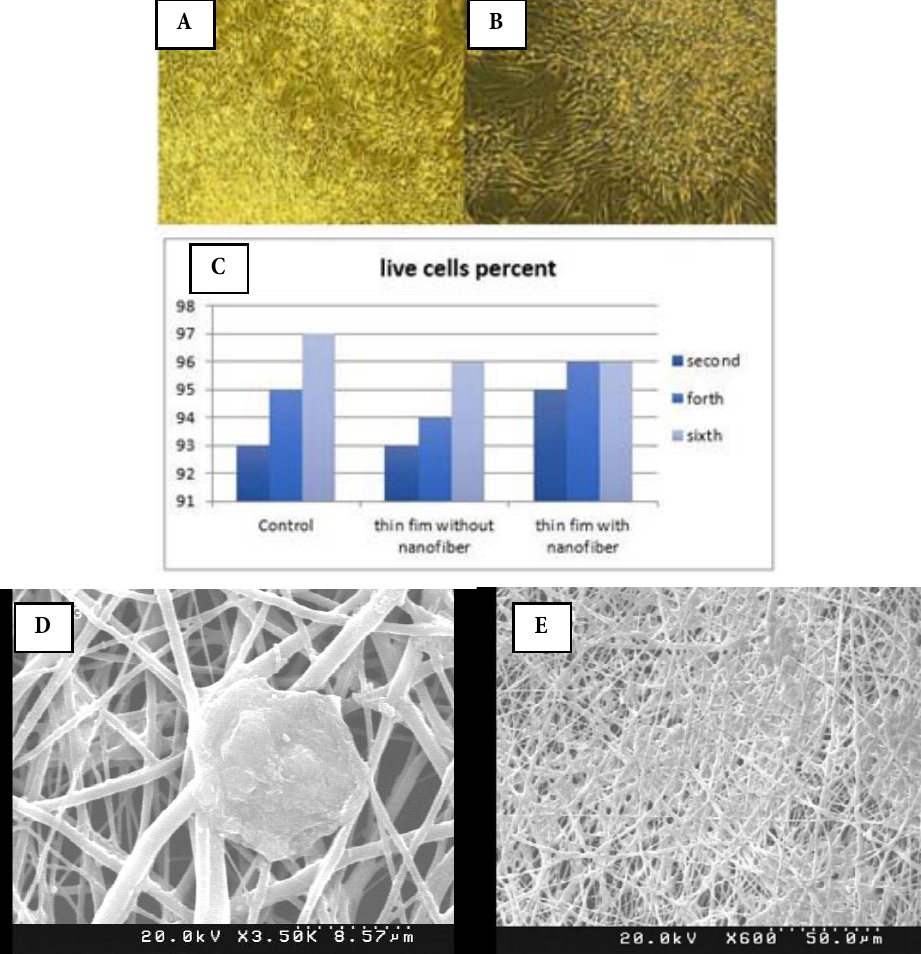
Fig. 8. Fibroblast cells in DMEM on the films (A) with and (B) without nanofiber under inverted microscope, (C) Curves of percentage of live cells after 2, 4 and 6 days, (D,E) SEM image of fibroblast cells on the film containing nanofiber